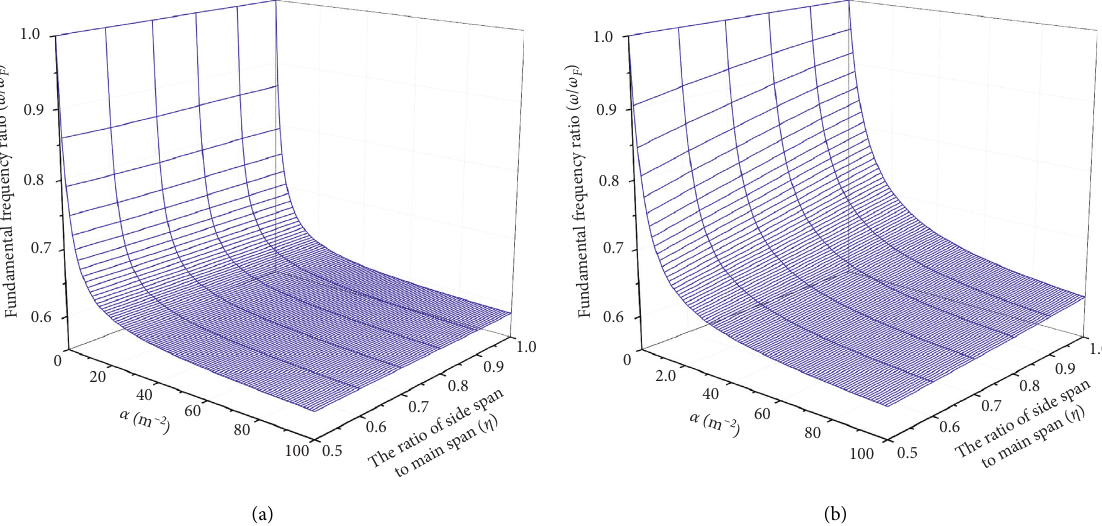
Figure 11: The values of ω / ω F of SCCCB with different ratios of the side span to the main span. (a) Equal total length. (b) Equal main span